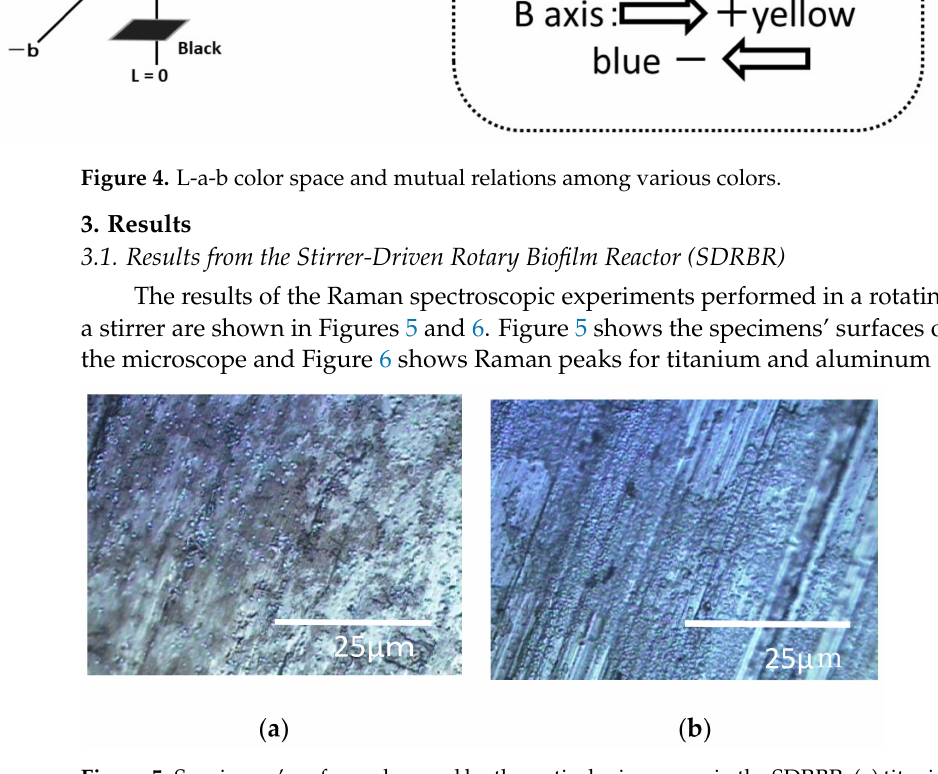
Figure 5. Specimens’ surfaces observed by the optical microscope in the SDRBR: ( a ) titanium specimen and ( b ) aluminum